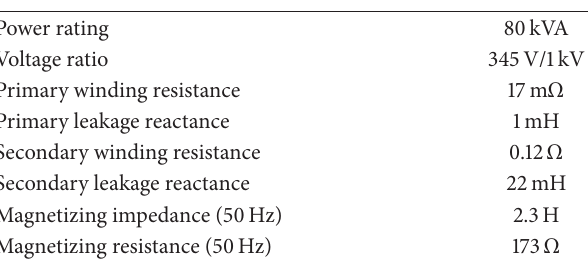
Table 3: Transformer